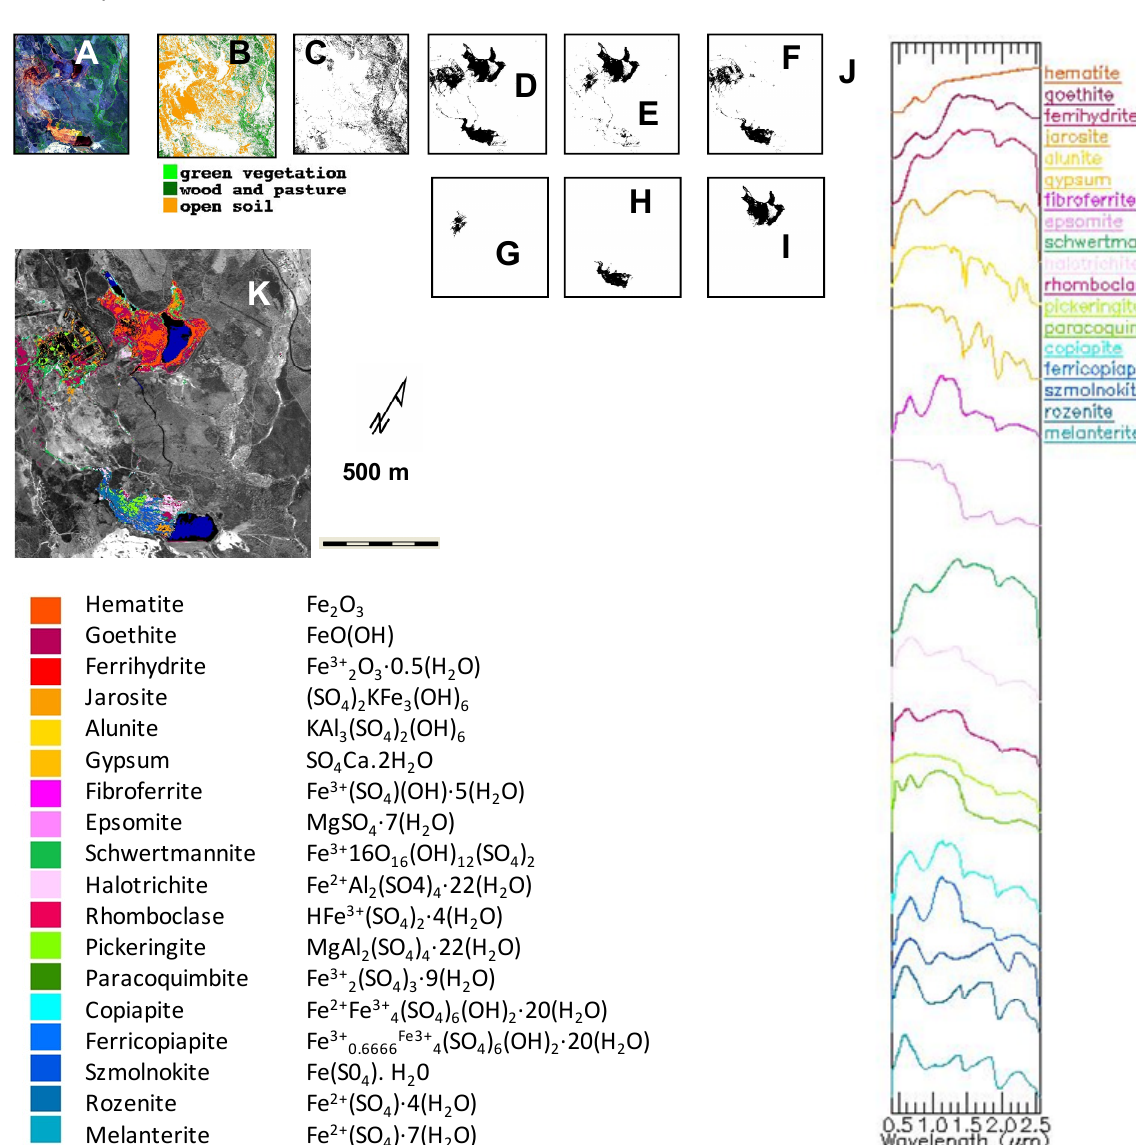
Figure 2. Sequential subscenes produced by image processing (from left to right). ( A ) False color composite with HyMap Channels 9 (0.5568 μ m), 28 (0.8460 μ m) and 109 (2.2074 μ m). ( B ) Land use map estimating vegetation cover and open soil. ( C ) Mask for vegetation. ( D ) Mask for mine waste. ( E ) Mask for hydrated tailings. ( F ) Mask for oxidated dumps. ( G ) Mask for hydrated ponds around the ore processing plant. ( H ) Mask for the hydrated mill tailings dam. ( I ) Mask for the oxidated pond of ashes. ( J ) Spectral reference library on pyrite weathering products [19,20]. Spectra are displaced vertically for clarity. ( K ) Final map of coatings of pyrite weathering products over mine waste following the reference spectral library [19]. Color coding for minerals mapped with the corresponding chemical formula are arranged in a precipitation and oxidation sequence. Increasing reddish colors suggest intense oxidation. Bluish and greenish colors concentrate on hydrated